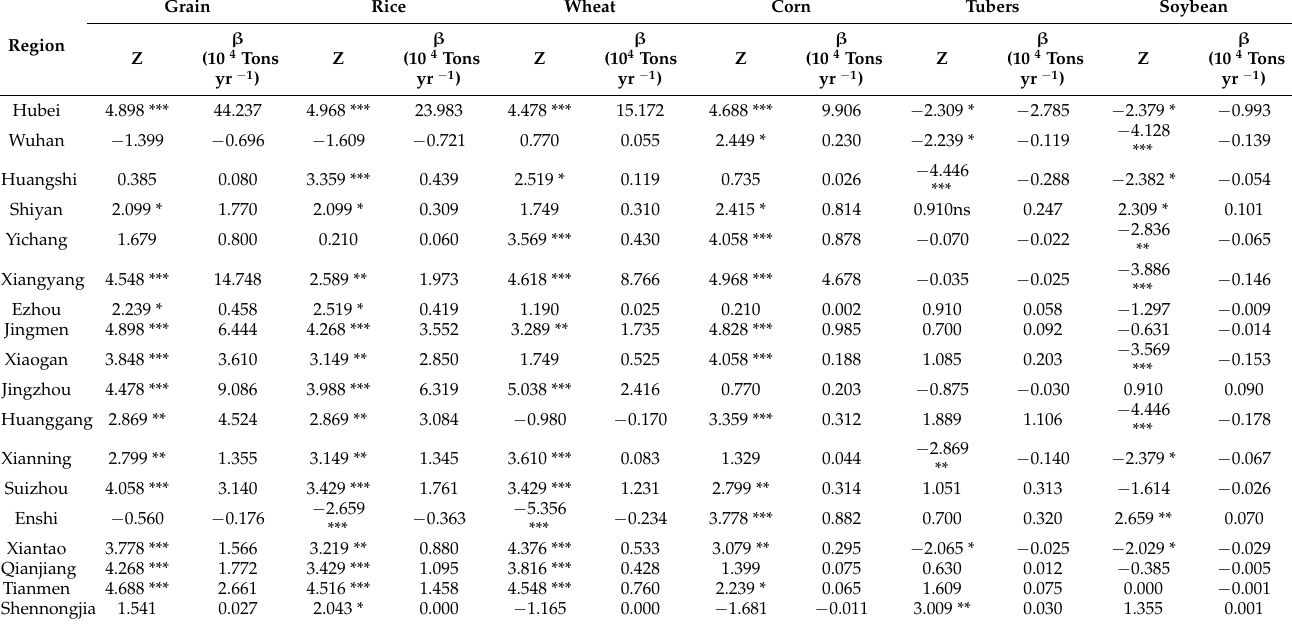
Table 3. Mann–Kendall trend analysis for the total grain yield and the yield of five specific farm crops from 2000 to